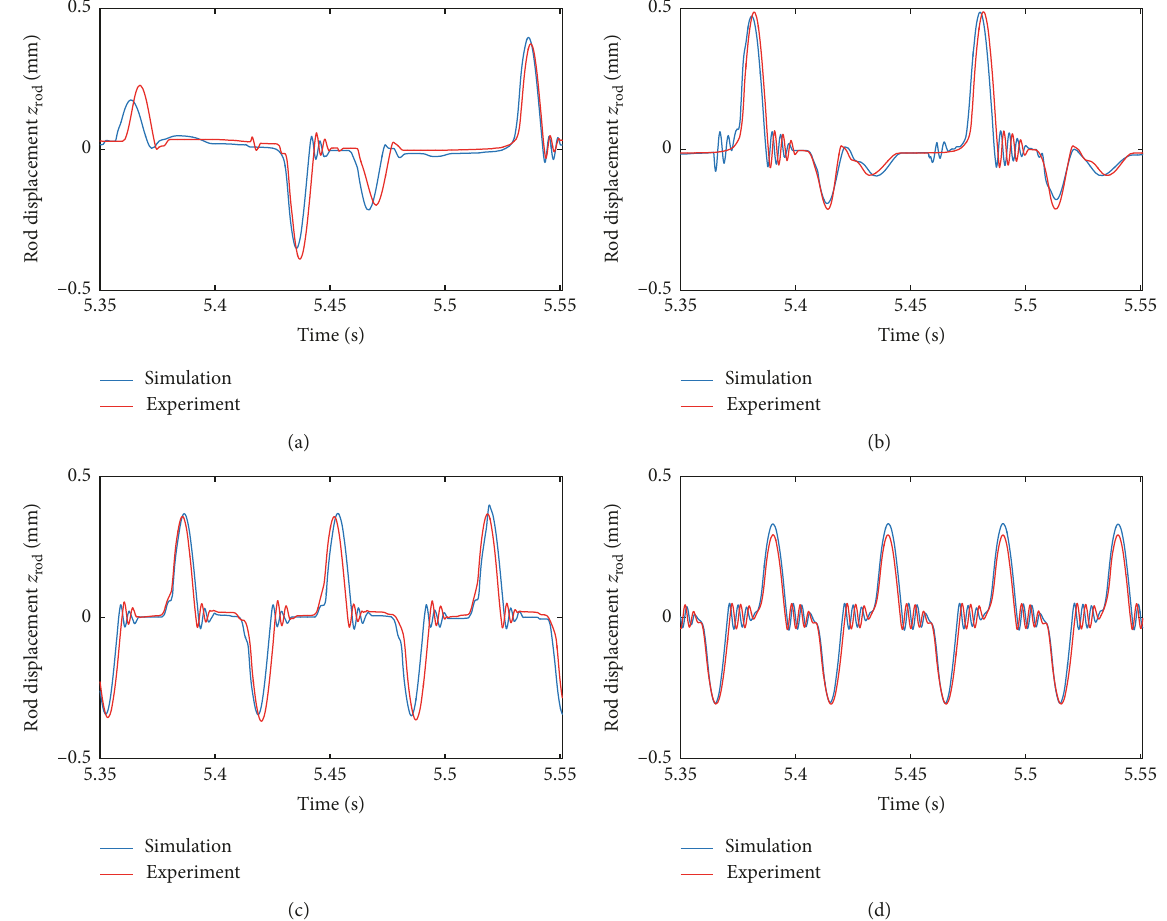
Figure 26: Displacements z rod in numerical and experimental studies with different frequencies: (a) 5 Hz, (b) 10Hz, (c) 15Hz, and (d)